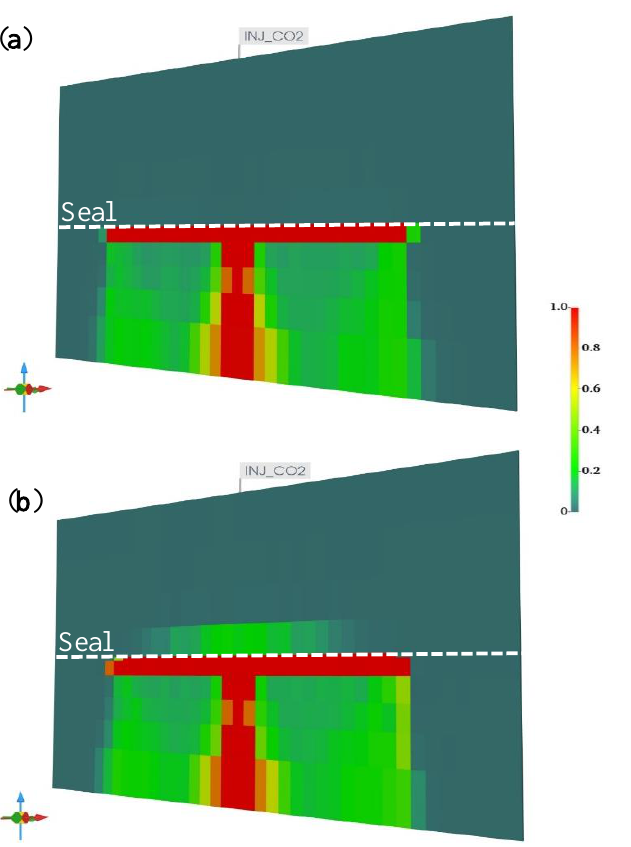
Figure 11. Vertical plane slice through a reservoir model showing a comparison of the CO 2 plume behaviour between models of sandstone aquifers with shale inter-layers (dashed line) with thicknesses of 0.3 m ( a ) and 3 m ( b ) for the simulation of 120 years of injection. The colour scale represents increasing concentrations of CO 2